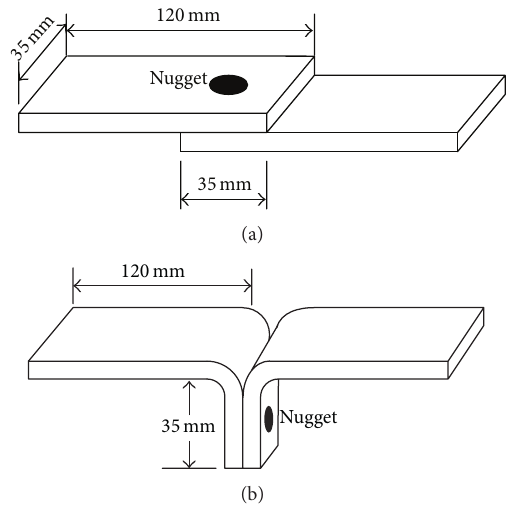
Figure 1: (a) Lap-shear tensile test specimen; (b) peel-tensile test